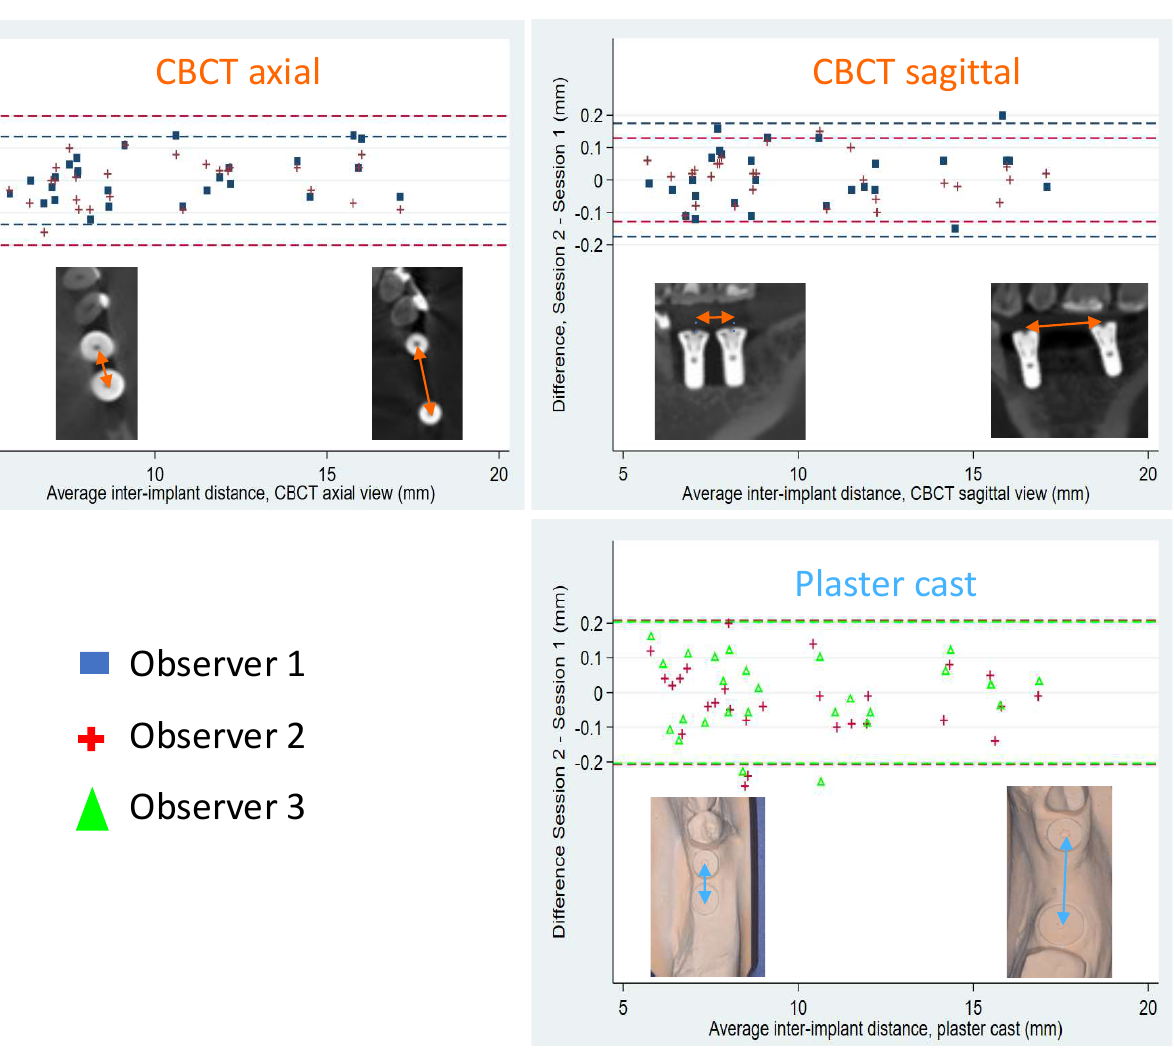
Figure 3. Bland–Altman diagrams show intra-observer repeatability coefficients and 95% limits of agreement for observers 1 and 2 on CBCT views and for observers 2 and 3 on plaster casts. Inter- implant distances ranged from 5.6 mm to 17.1 mm (photo insets). The representation of the mean difference (middle solid line), the confidence interval limits for mean (upper and lower solid lines) and the 95% agreement limits (dotted lines) are shown on the diagrams.